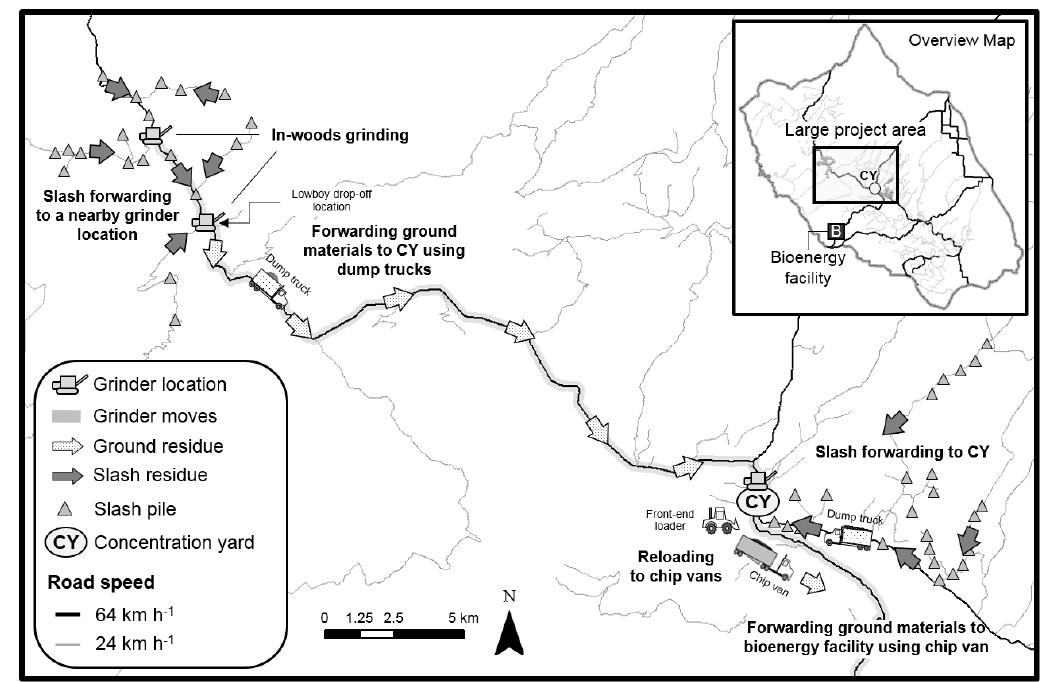
Figure 9. Optimized feedstock logistics for a larger project area (58 log landings) presenting biomass flow, selected on-site grinding locations, and the use of concentration yard for transshipment.